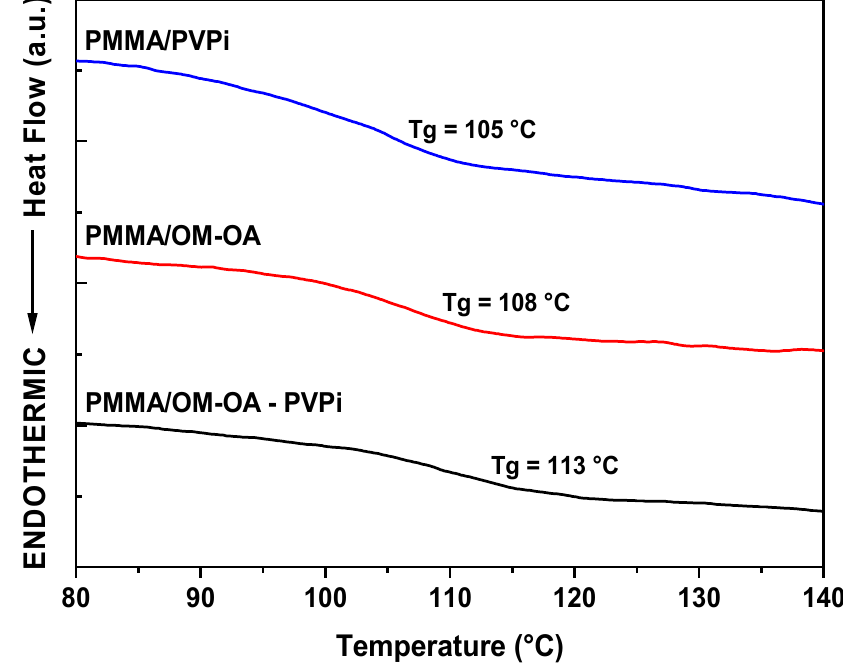
Figure 7. DSC curves of the PMMA/OM-OA and PMMA/OM-OA/poly(vinyl pivalate) (PVPi) samples.